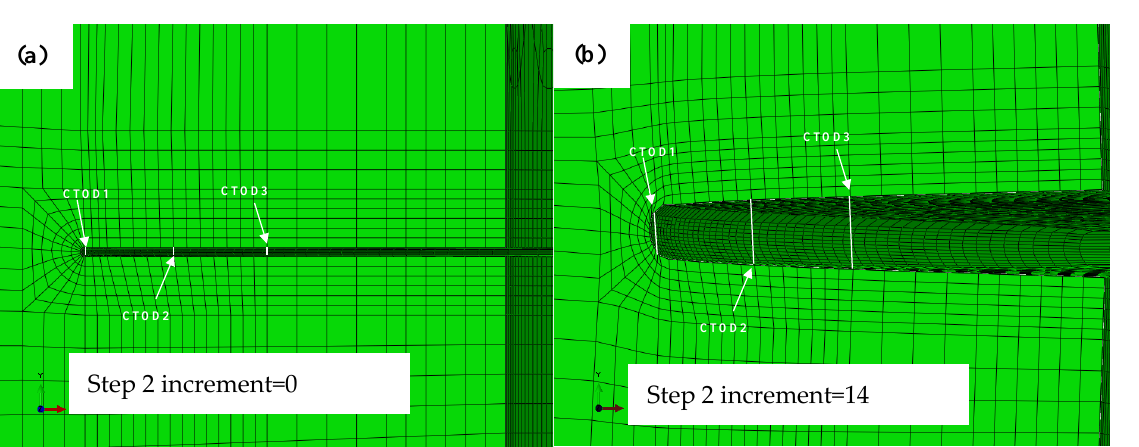
Figure 10. Crack growth driving force curves calculated using FEA results.